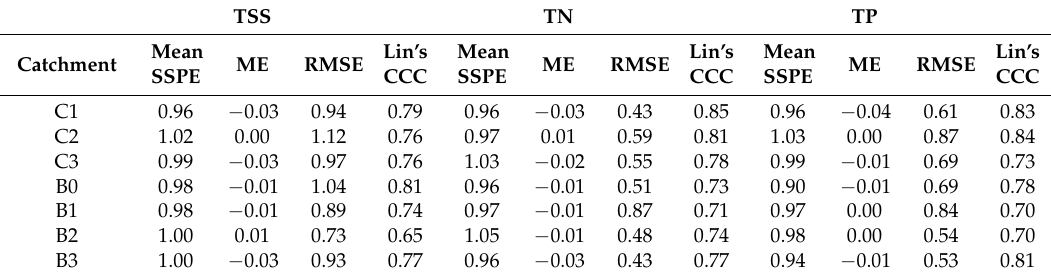
Table 5. Model performance.